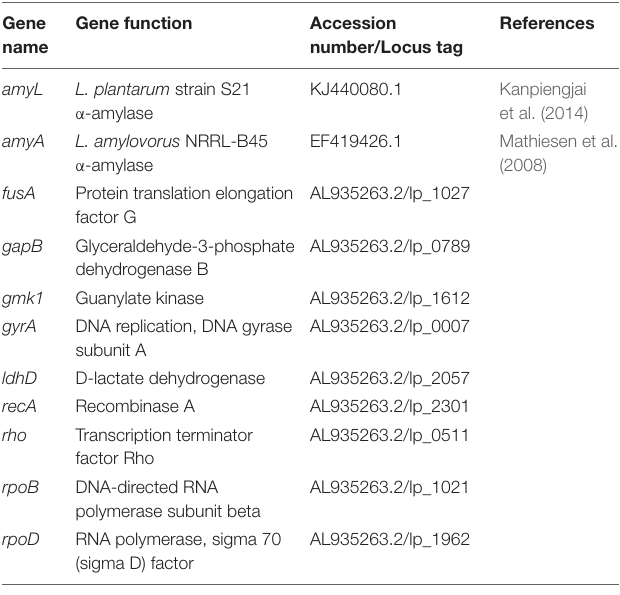
TABLE 1 | Target and housekeeping genes used in this